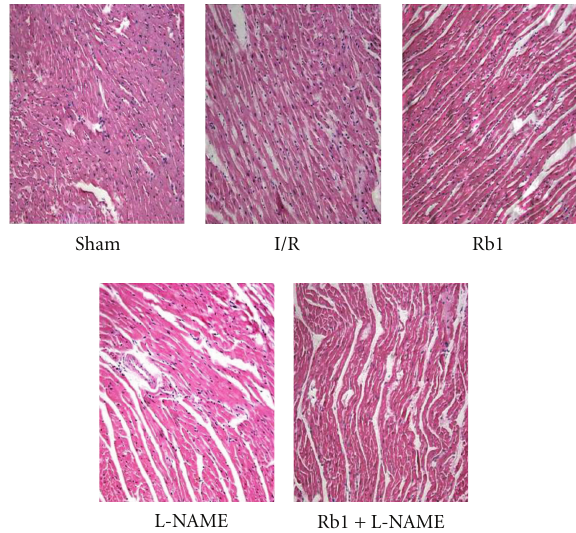
Figure 6: Histopathological slides of the diabetic rats heart tissue (magnification, ×